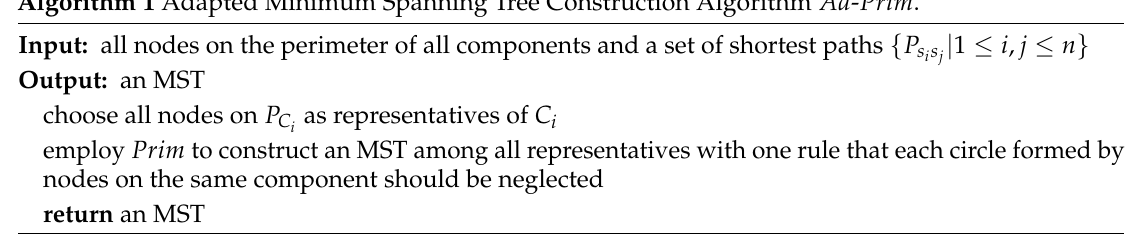
Algorithm 1 Adapted Minimum Spanning Tree Construction Algorithm Ad - Prim